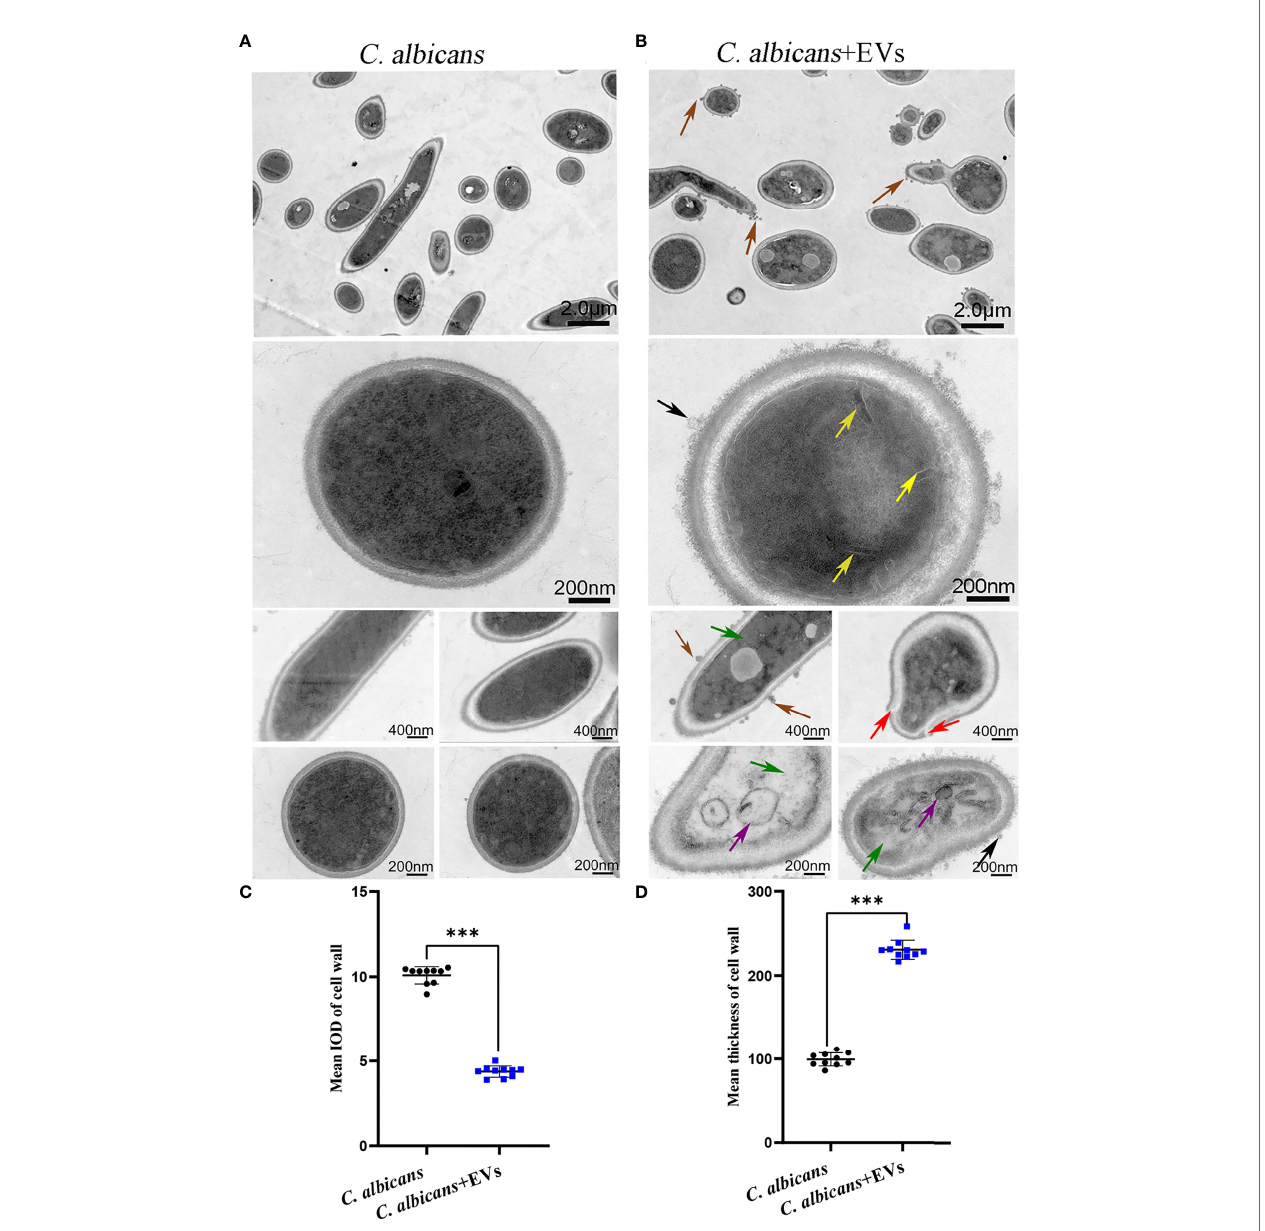
FIGURE 5 | TEM analysis of C. albicans . (A) Representative TEM images of the C. albicans group. (B) Representative TEM images of C. albicans treated with Leuk-1-EVs for 12h. The untreated C. albicans cells displayed smooth and intact cell walls, and the cytoplasm was homogeneous in (A) . In contrast, exposure to EVs caused several alterations, including uneven or inhomogeneous plasma (green arrows), increased mucus protein on the cell wall (black arrows), protrusions on the cell wall (brown arrows), an incomplete cell wall (red arrows), an inner roll of the cell membrane (yellow arrows), and evident mitochondrial edema (purple arrows) in (B) . The scale bars in the panels are as indicated. (C) Changes in the mean IOD of C. albicans cell wall at 12 h. The mean IOD in the C. albicans + EVs group is signi fi cantly lower than that in the C. albicans group. (D) Changes in the mean thickness of C. albicans cell wall at 12 h. The mean thickness in the C. albicans + EVsgroup signi fi cantly increased compared with that of the C. albicans group. Statistical signi fi cance was tested by Mann-Whitney U test. ***P <